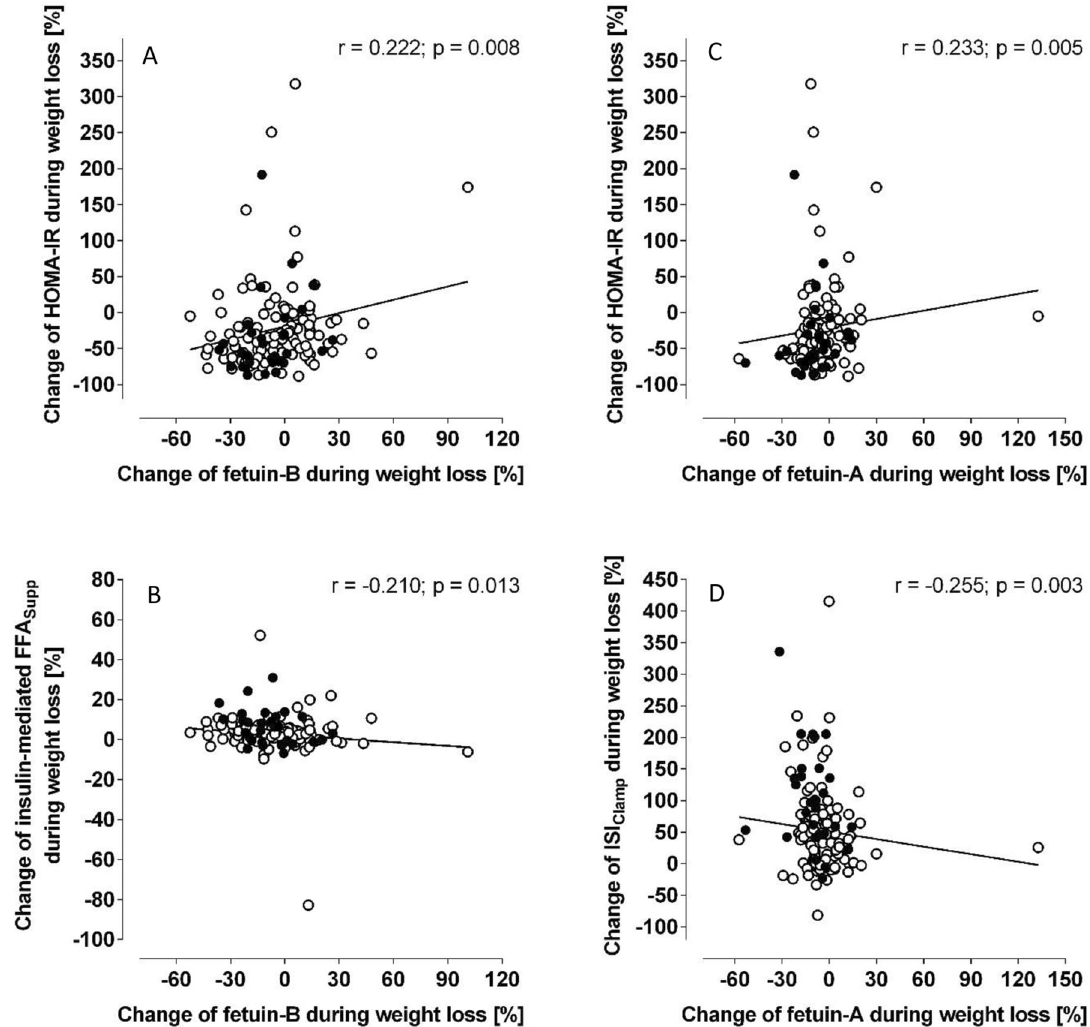
Fig. 1 Association of weight loss-induced changes of Fetuin-A and Fetuin-B with reduction of HOMA-IR, insulin sensitivity index (ISI Clamp ), and insulin-mediated suppression of FFAs (FFA Supp ) during weight loss. Data were presented for men ( fi lled circle) and women (open